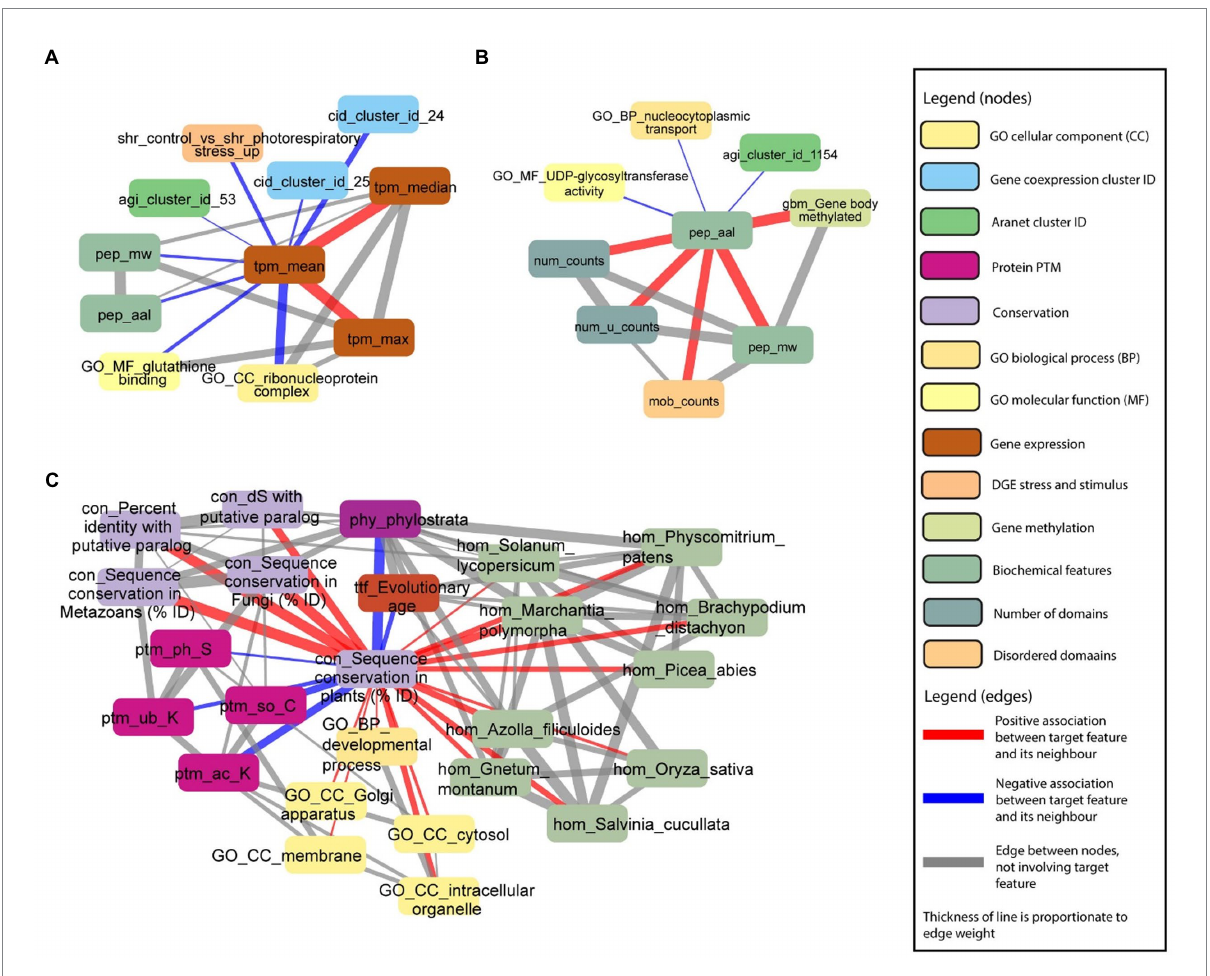
FIGURE 7 Examples capturing protein sizes and conservation. Selected nodes and edges from the local neighbourhood of specific features in the database are shown. (A) Mean gene expression (tpm_mean) is positively associated with maximum (tpm_max) and median (tpm_median) gene expression. (B) Protein length (pep_aal) is positively associated with the number of protein domains (num_counts), number of unique protein domains (num_u_counts), number of disordered protein domains (mob_counts) and protein molecular weight (pep_mw). (C) Sequence conservation in plants [con_Sequence_conservation_in_plants_(%_ID)] is positively associated with sequence conservation in paralogs, fungi and metazoans (nodes starting with “con_”), fundamental GO terms (nodes starting with “GO_”), and homology with multiple plant species (nodes starting with “hom”). Sequence conservation in plants is negatively associated with the evolutionary age of target genes of transcription factors (ttf_ Evolutionary_age), phylostrata (phy_phylostrata), and protein PTMs (nodes starting with